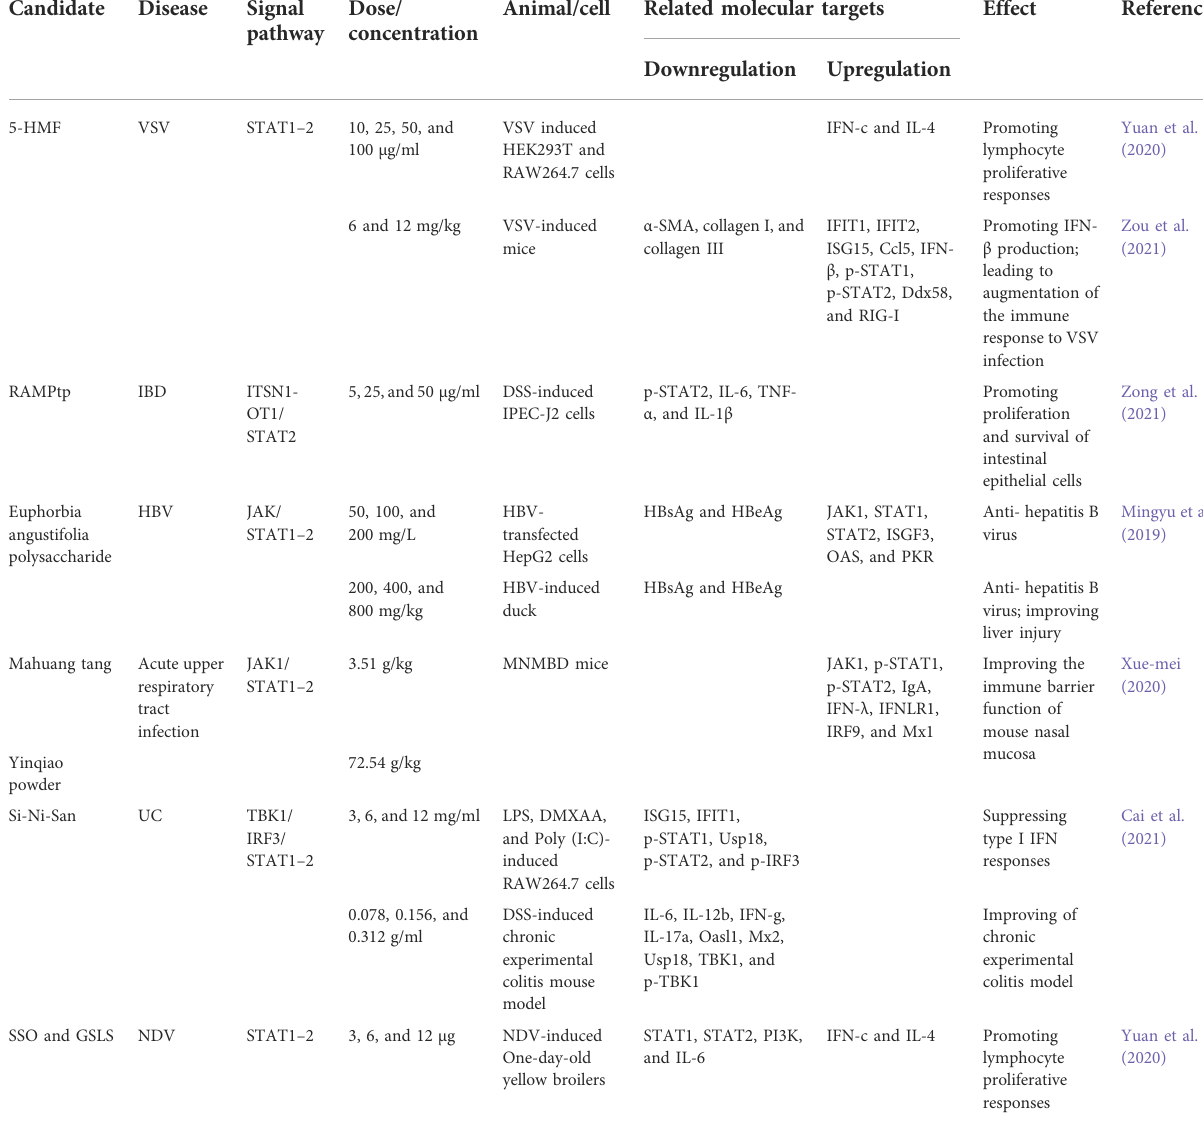
TABLE 2 Chinese herbal formulas or active ingredients in the treatment of infected or in fl ammatory diseases through in fl uencing